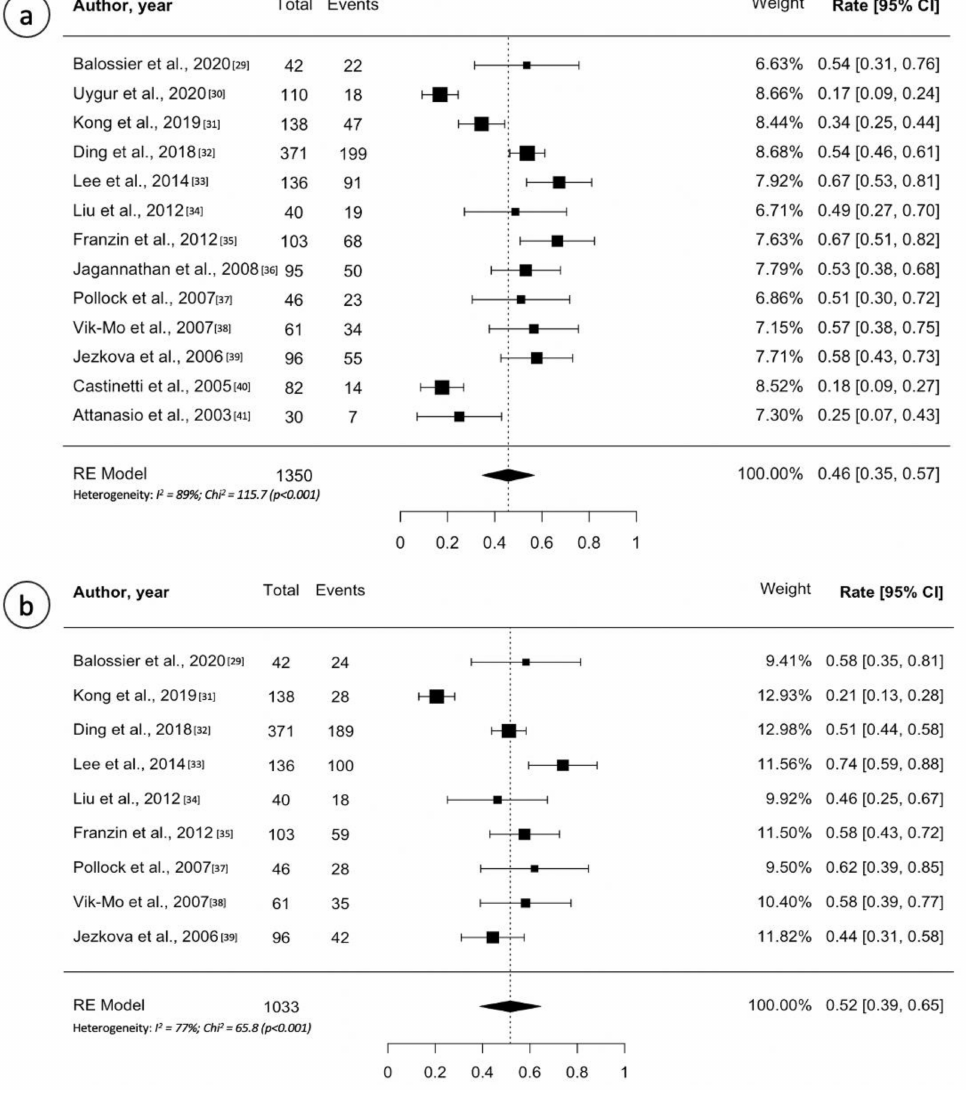
Figure 3. ( a ) Forest plot of overall tumor control following Gamma Knife treatment for growth hormone-secreting pituitary adenomas; ( b ) Forest plot of 5-year recurrence-free survival after Gamma Knife treatment for growth hormone-secreting pituitary adenomas. Random effects models pooled estimates are presented and heterogeneity analysis are